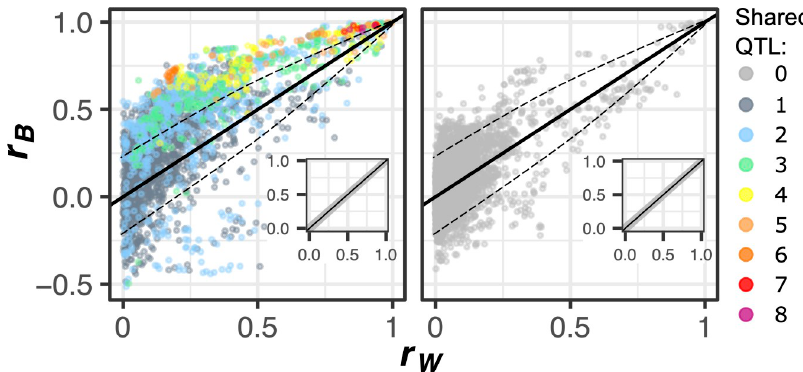
Fig 3. Natural genetic variation affects the correlation between morphological features. The absolute value of the between-strain correlation ( r B ), made negative when r B and r W have opposite signs, is plotted against the absolute value of the within-strain correlation ( r W ), for each pair of traits. The plot at left shows pairs of traits that share at least one QTL influence. The color of each point represents the number of pleiotropic QTL that influence both traits in that pair. The plot at right shows pairs of traits that share no QTL influence. The dashed line represents a Bonferroni-corrected significance threshold of p < 0.01. Insets represent the results of correlation partitioning performed after randomly assigning individual cells to groups (pseudo-strains) having the same numbers of cells as the actual strains. Data underlying this figure can be found at https://osf.io/b7ny5/. QTL, quantitative trait loci.